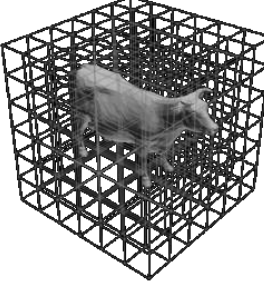
Figure 3. The concept of the CSS method. Each greys cube is the subspace of a 3D model, and each has an associated label to show whether they contain a collision in the 3D model.